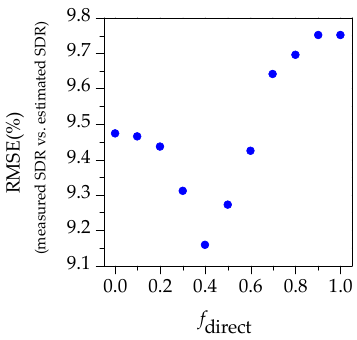
Figure 11. The impact of threshold f direct on the RMSE of SDR estimation.